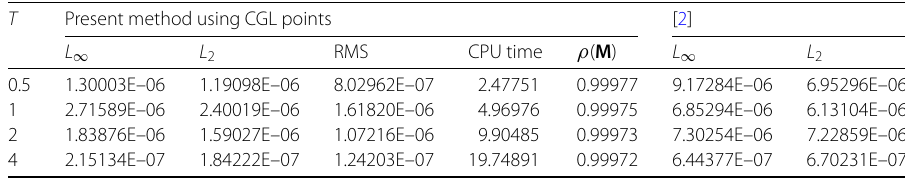
Table 7 Error norms and spectral radius for the solution of Example 2 in Case 2.1